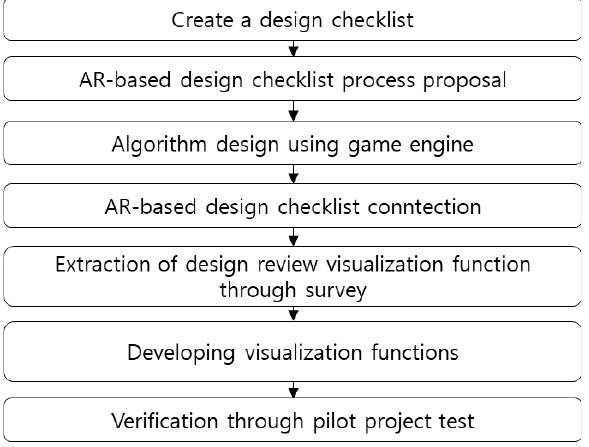
Figure 1. Method and procedure.